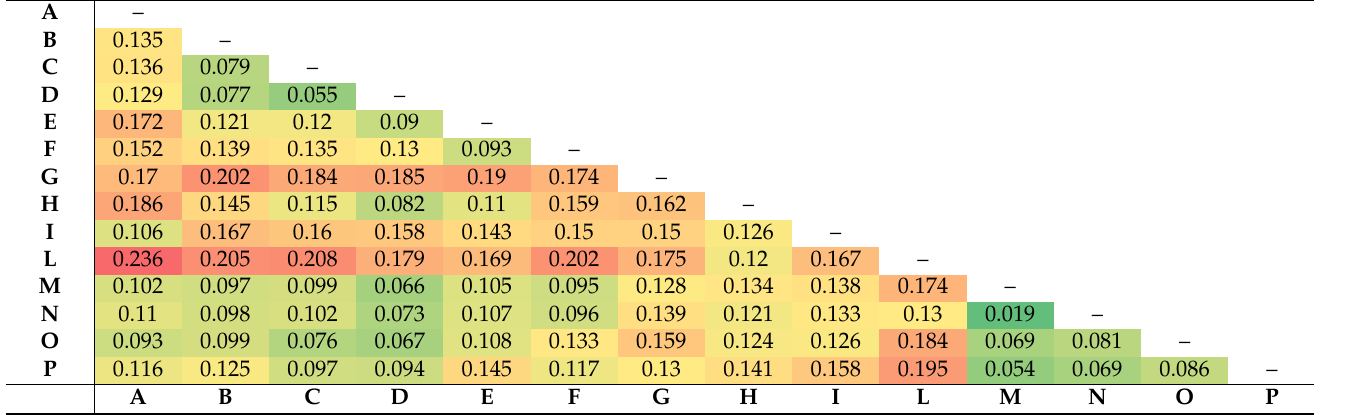
Table 5. Matrix with Nei’s gene diversity (G ST ) values (analogous to F ST ) for all possible pairwise com- parisons between the 14 varieties. Green and red indicate lower and higher G ST values,